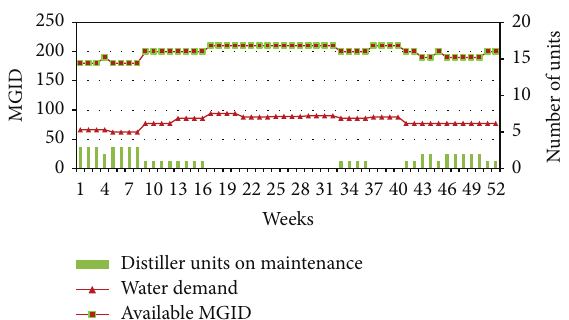
∗ The gap average of electricity = 1974.04. ∗∗